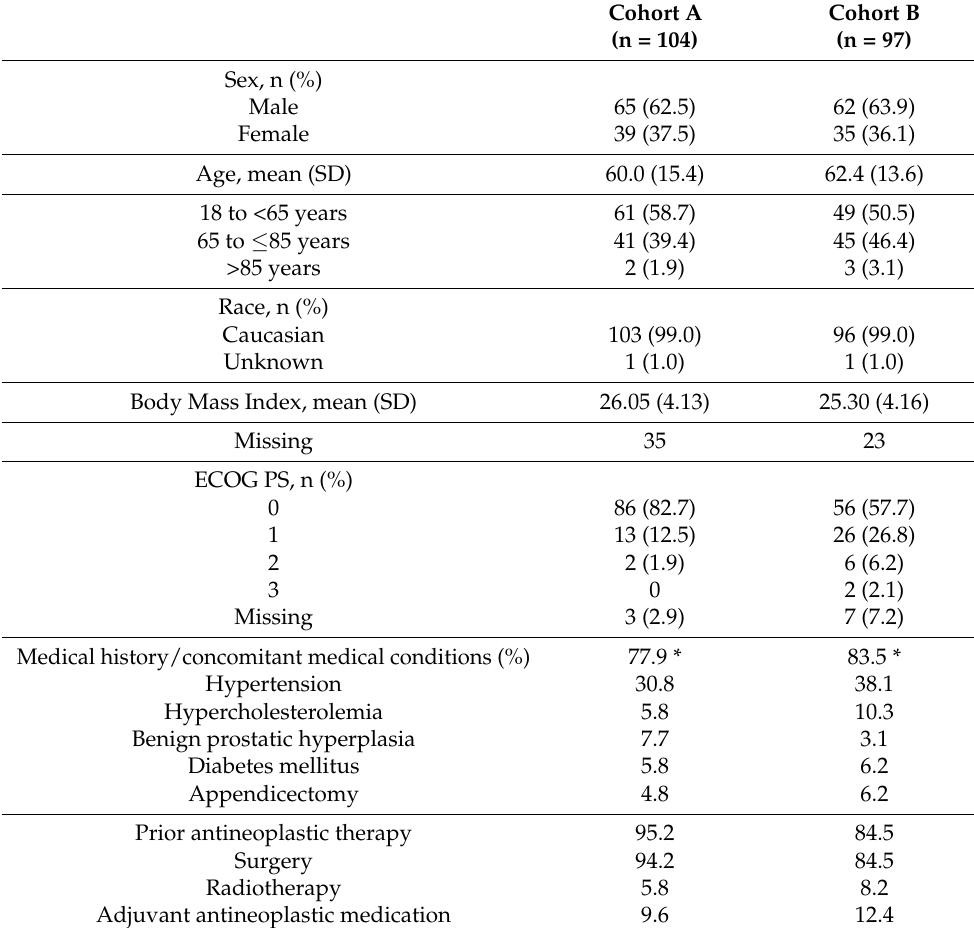
Table 1. Demographic and baseline